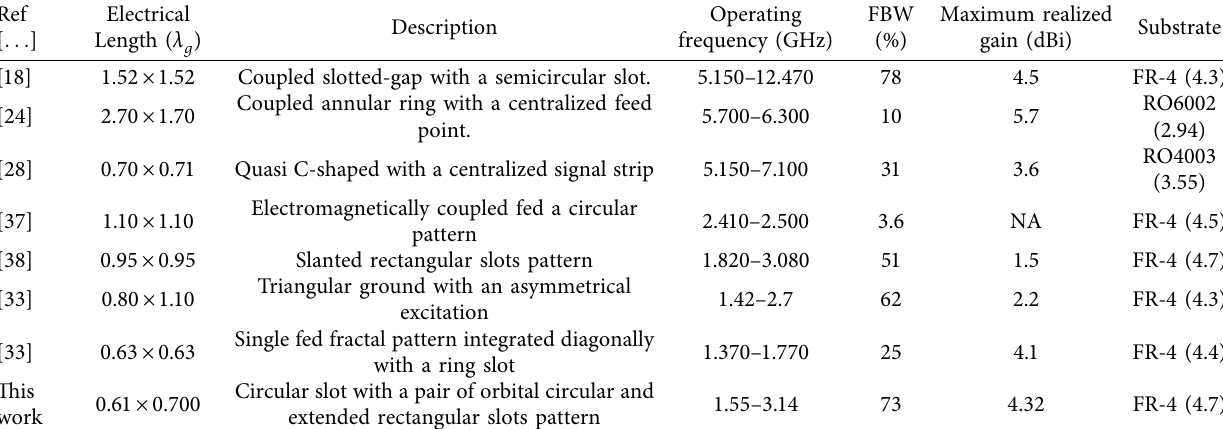
Table 1: Comparison of the proposed wideband circular-slot antenna with the related work.